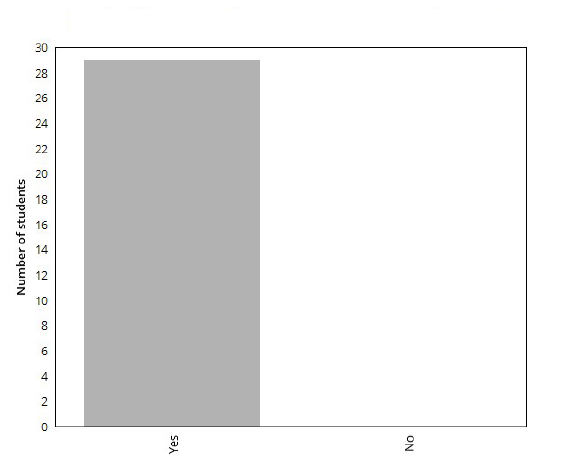
Figure 8. Did the EIMS framework help to analyse the site? Figure 9. Did the EIMS framework help to undertake in-depth